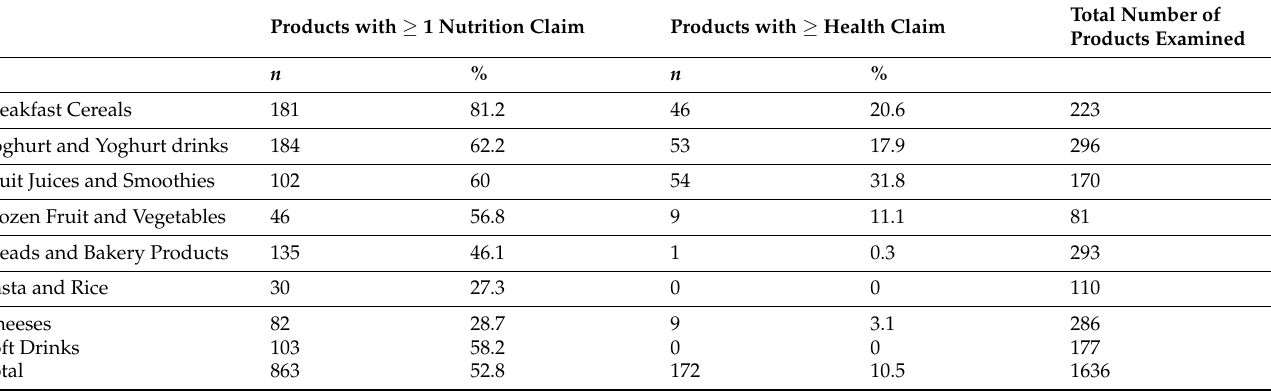
Table 5. Prevalence of nutrition and health claims in 2021 by food